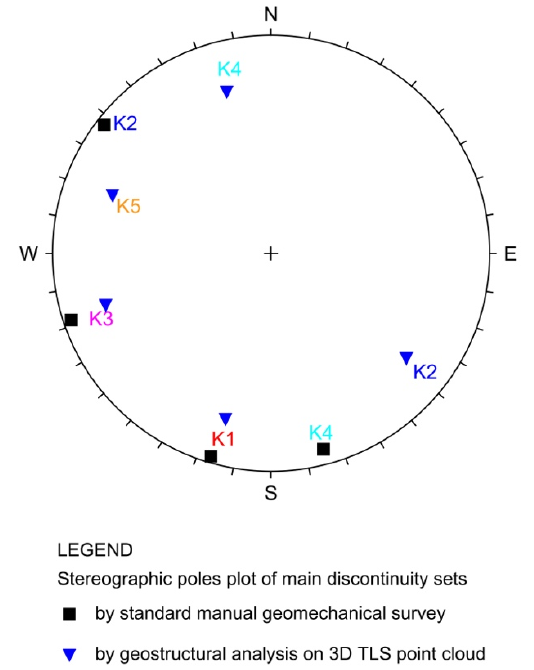
Figure 8. Stereoplot comparing the data from the two different techniques.